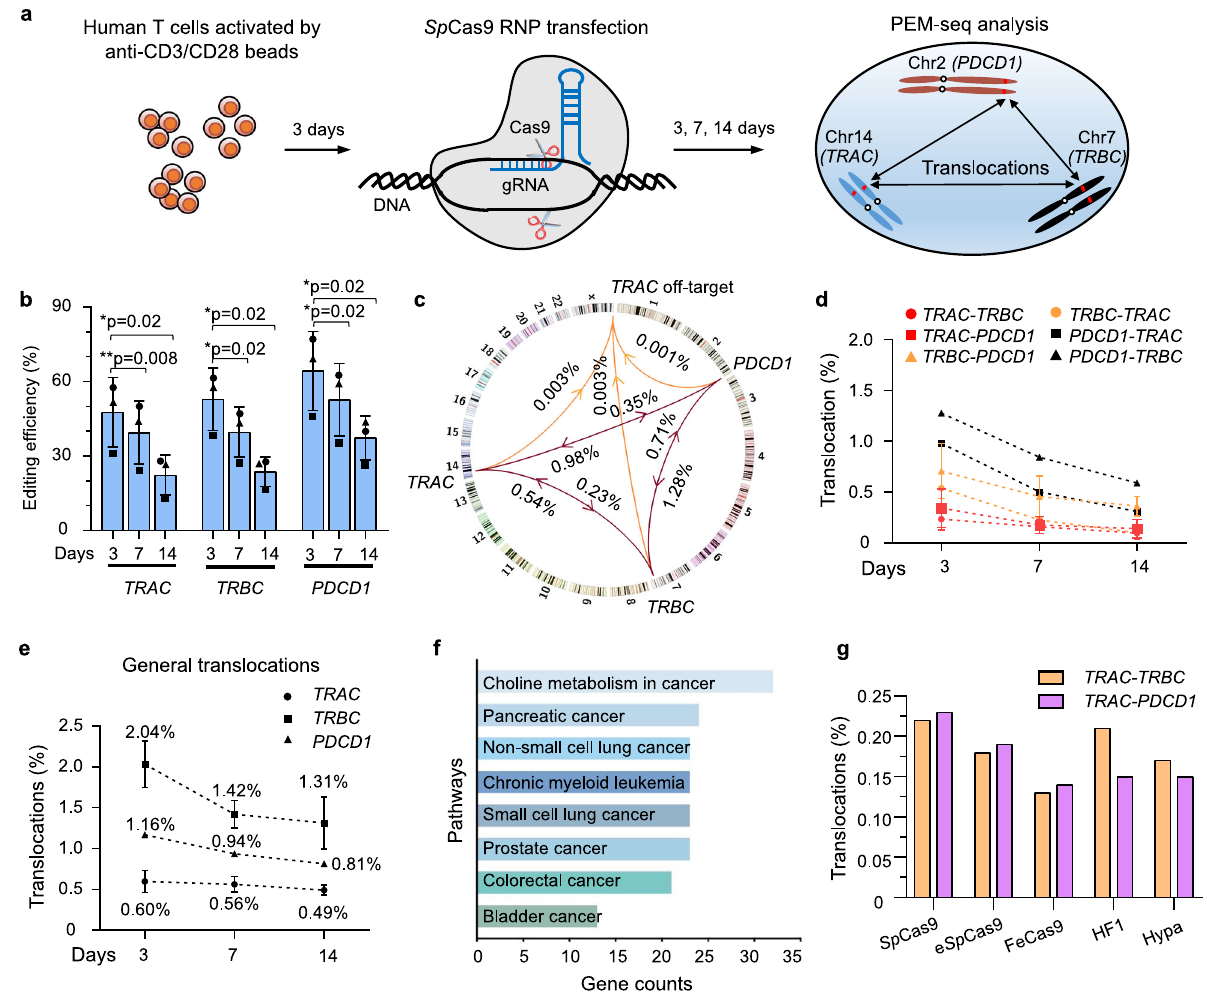
Fig. 1 Translocations during Sp Cas9-mediated multiplex gene editing in human T cells. a Schematics for assessing chromosomal translocations during multiplex gene editing by Sp Cas9 RNPs in human T cells. Chr represents Chromosome. b Editing ef fi ciency for TRAC , TRBC , and PDCD1 in human T cells at 3-, 7-, and 14-days post-transfection detected by PEM-seq. Mean± SD from three biological replicates, represented by “ circle ” , “ triangle ” , and “ square ” , respectively. Paired two-tailed t -test, * p < 0.05 and ** p < 0.01. c Circos plot indicating translocations among TRAC , TRBC , PDCD1 , and the TRAC off-target in human T cells at 3-days post-transfection detected by PEM-seq. Chromosomes are shown with centromere to telomere in the clockwise direction. The averages of three replicates are shown on each line, and the arrows indicate the orientation of bait to prey. d Percentages for translocations among TRAC , TRBC , and PDCD1 detected by PEM-seq in human T cells at 3-, 7-, and 14-days post-transfection. The translocations were categorized as bait-prey, e.g., TRAC-TRBC represented the translocations between TRAC and TRBC cloned with a bait primer located at TRAC . Mean ± SD from three biological replicates. e Percentages for general translocations in human T cells cloned from the indicated loci at 3-, 7-, and 14-days post-transfection detected by PEM-seq. Mean± SD from three biological replicates. Mean values are marked above each data point. f Gene annotation for total translocations from TRAC, TRBC , and PDCD1 in human T cells at 3-days post-transfection using the KEGG feature of Enrichr (maayanlab.cloud/Enrichr/). The horizontal axis indicates the gene numbers in the indicated pathway. g Percentages for the indicated translocations induced by Sp Cas9 and indicated variants detected by PEM-seq in human T cells cloned from TRAC at 3-days post-transfection, N = 1. Source data are provided as a Source Data fi